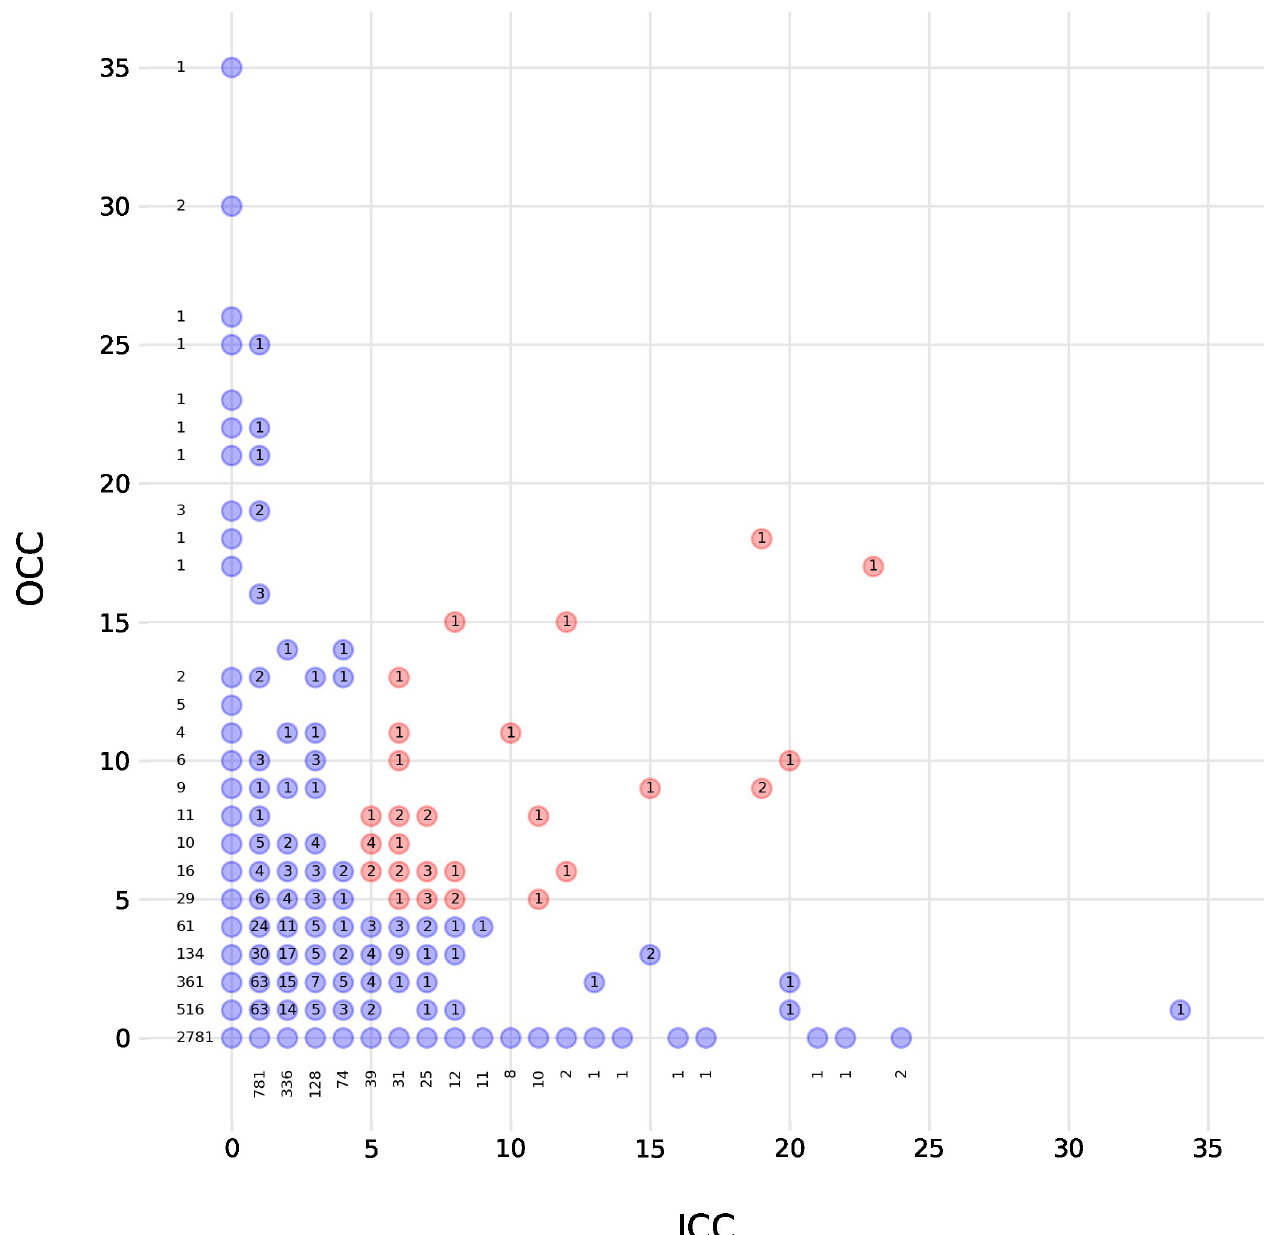
Fig 7. Scatterplot of OCC vs. ICC. The label assigned to every data point indicates the number of nodes (counts) with this combination of OCC and ICC values. For the sake of visibility, some counts are plotted next to the data point. Hubs are highlighted in red.